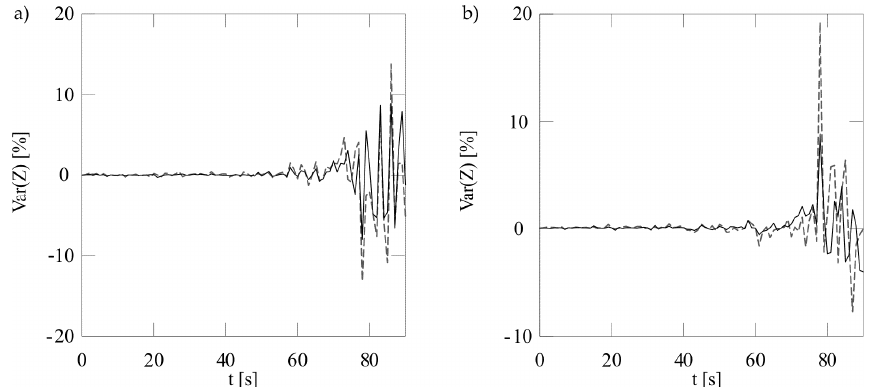
Figure 31. Percentage of variation of Z coordinate of load’s center of mass for wind power having impact according to the direction of the: ( a ) X axis and ( b ) Y axis (continuous line—V w = 10 m/s, dotted line—V w = 20 m/s).